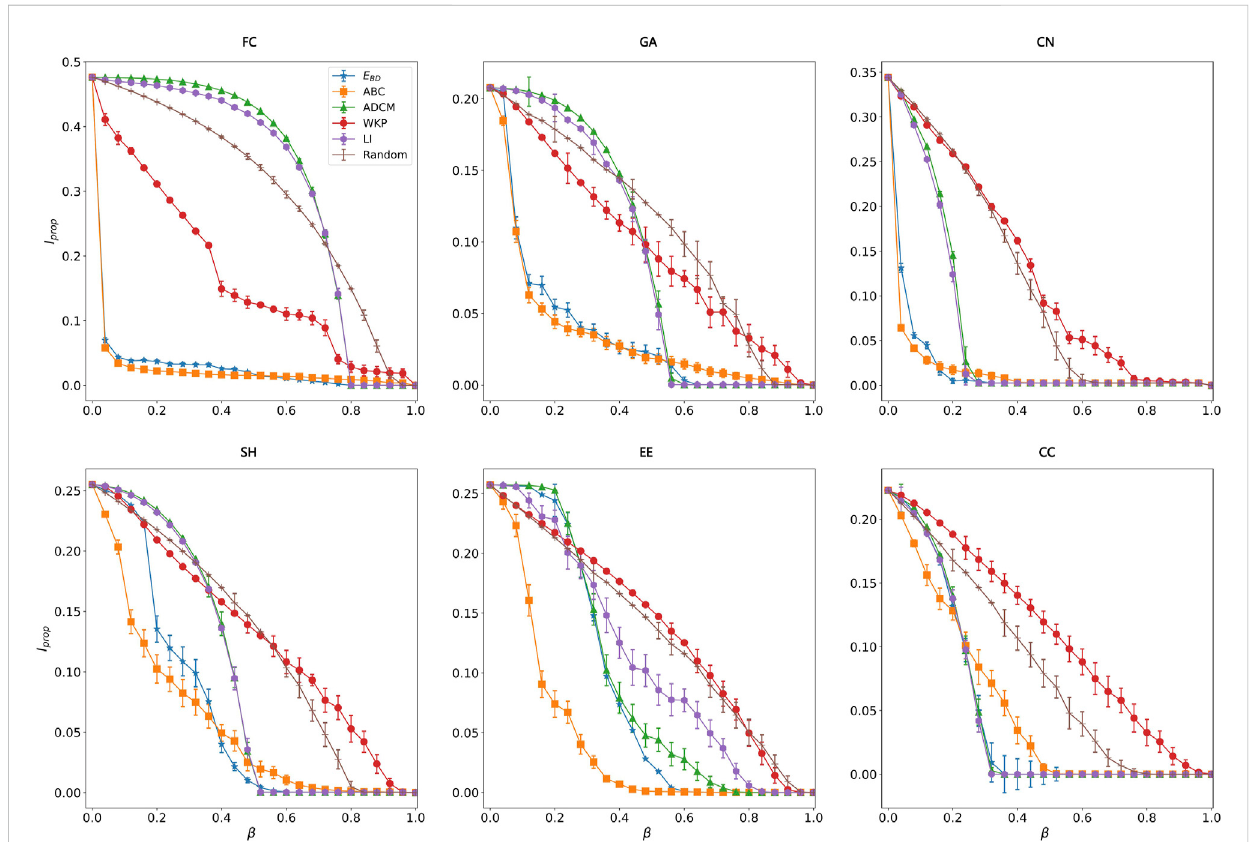
FIGURE 6 Performance of our method E BD ( α =0.5) and the others in epidemic suppression with experiments being conducted on six practical networks (i.e., FC, GA, CN, SH, EE and CC). The vertical axis represents the proportion of infectious nodes (i.e., I prop ) in the stationary state and the horizontal axis represents the proportion of edges being removed (i.e., β ), the error bars are displayed at each point. Note that, μ =0.06 and γ =0.5 in GA, FC and SH, μ =0.2 and γ =0.5 in CN and EE, μ =0.06 and γ =0.4 in